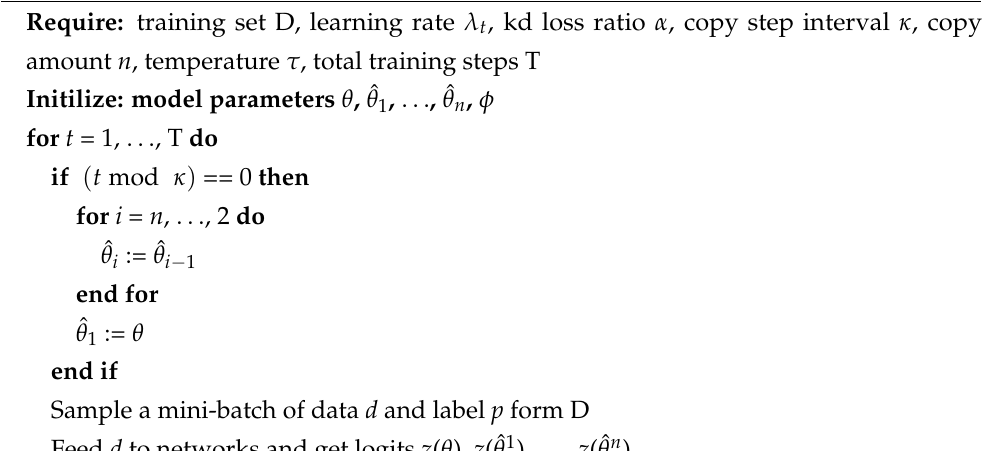
Algorithm 2 Memory Replay Knowledge